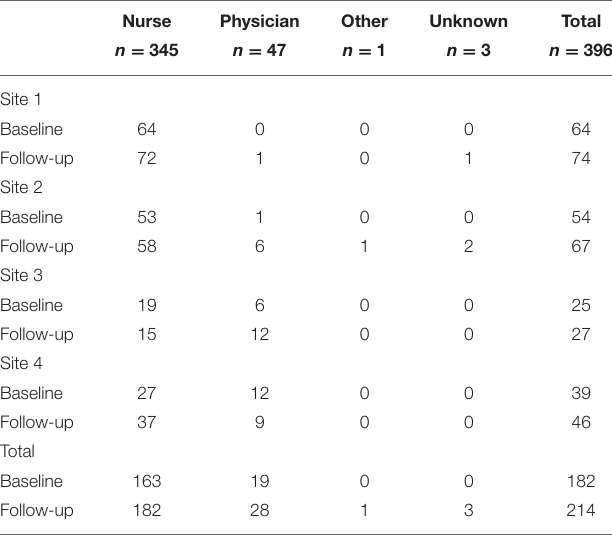
that had decreased follow-up scores at all sites.